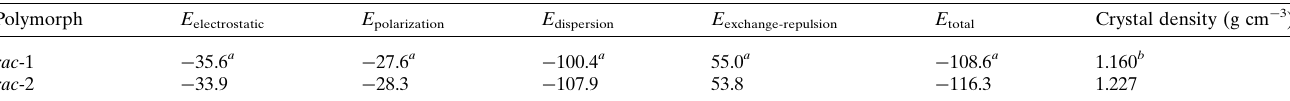
Table 2 Crystal lattice energies (kJ mol (cid:3) 1 ) for racemic 2-phenylbutyramide polymorphs computed using AA-CLP software. Polymorph